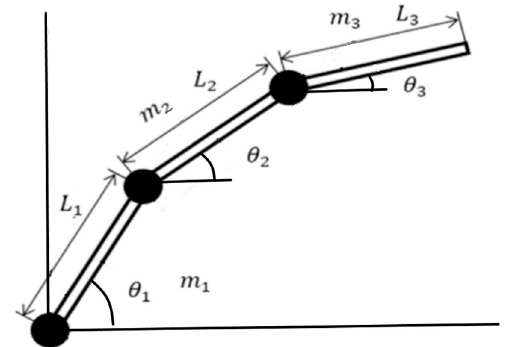
Figure 7. Finger links and labels.